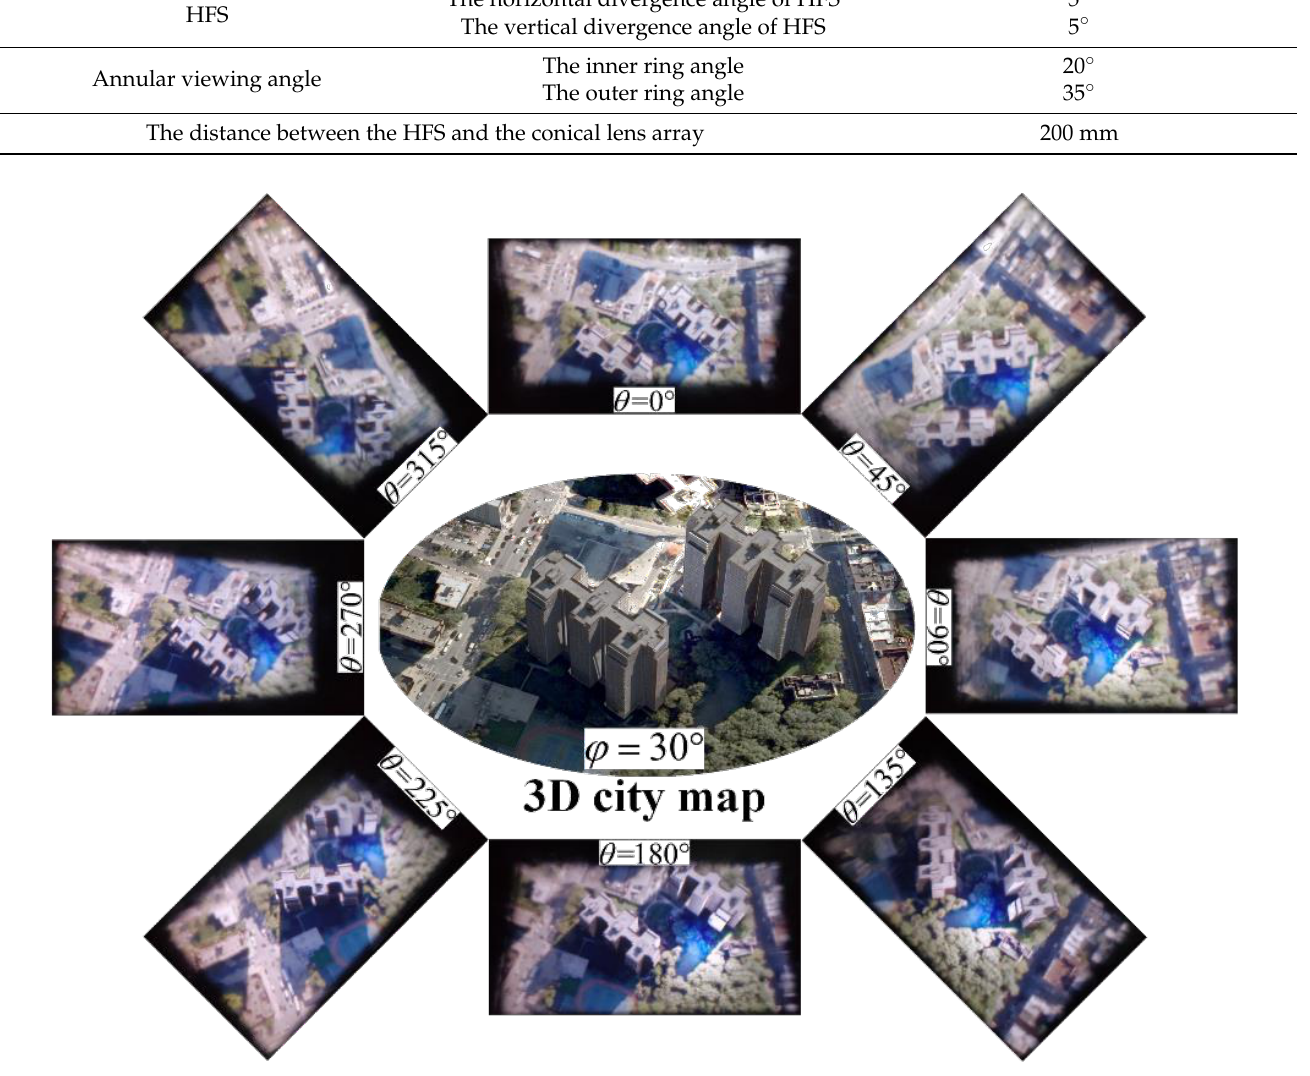
Figure 7. Different perspectives along the annular direction of the 3D electronic map (Video S1).